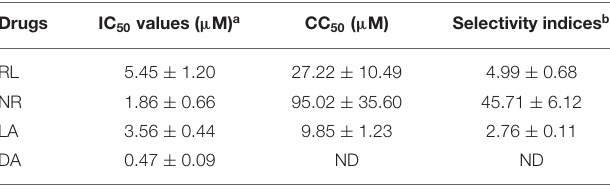
TABLE 1 | IC 50 , CC 50 , and selectivity indices of potent Natural compounds and diminazene aceturate evaluated against the in vitro growth of B. bovis .